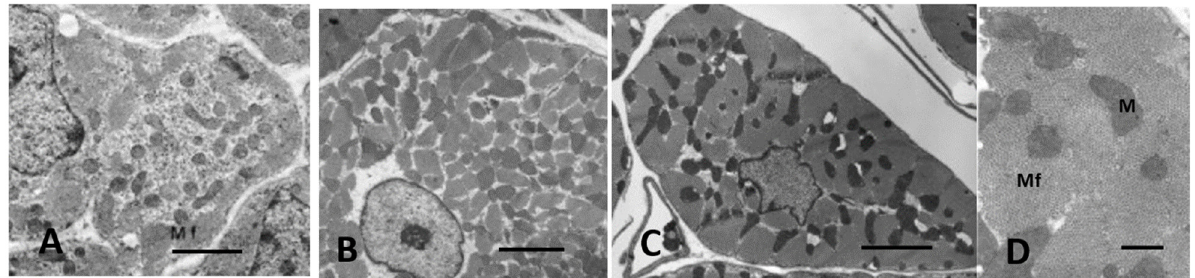
Figure 9. Electron micrographs of cross-sectioned LV myocytes from dogs. ( A ) neonatal, ( B ) normal adult, and ( C ) pressure overload LVH. ( D ) higher power myofilaments LVH myocardium. Myofibrils coalesce into a confluent mass with increasing hypertrophy. Mf = myofibril. M = mitochondria. Bars = 4 µm in ( A – C ), 2 µm in ( D ).